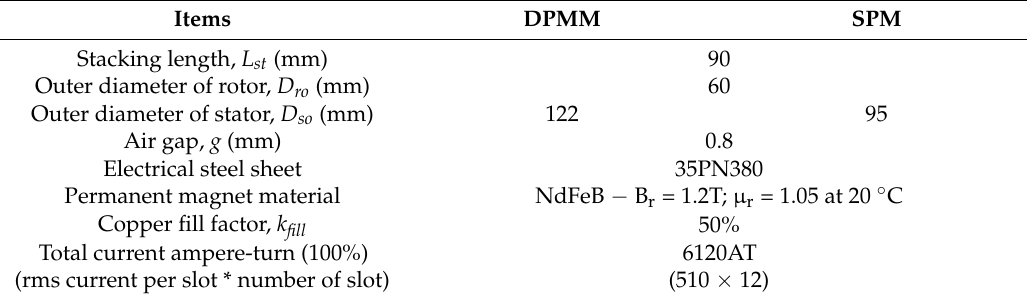
Table 2. Description of the two models for comparison.